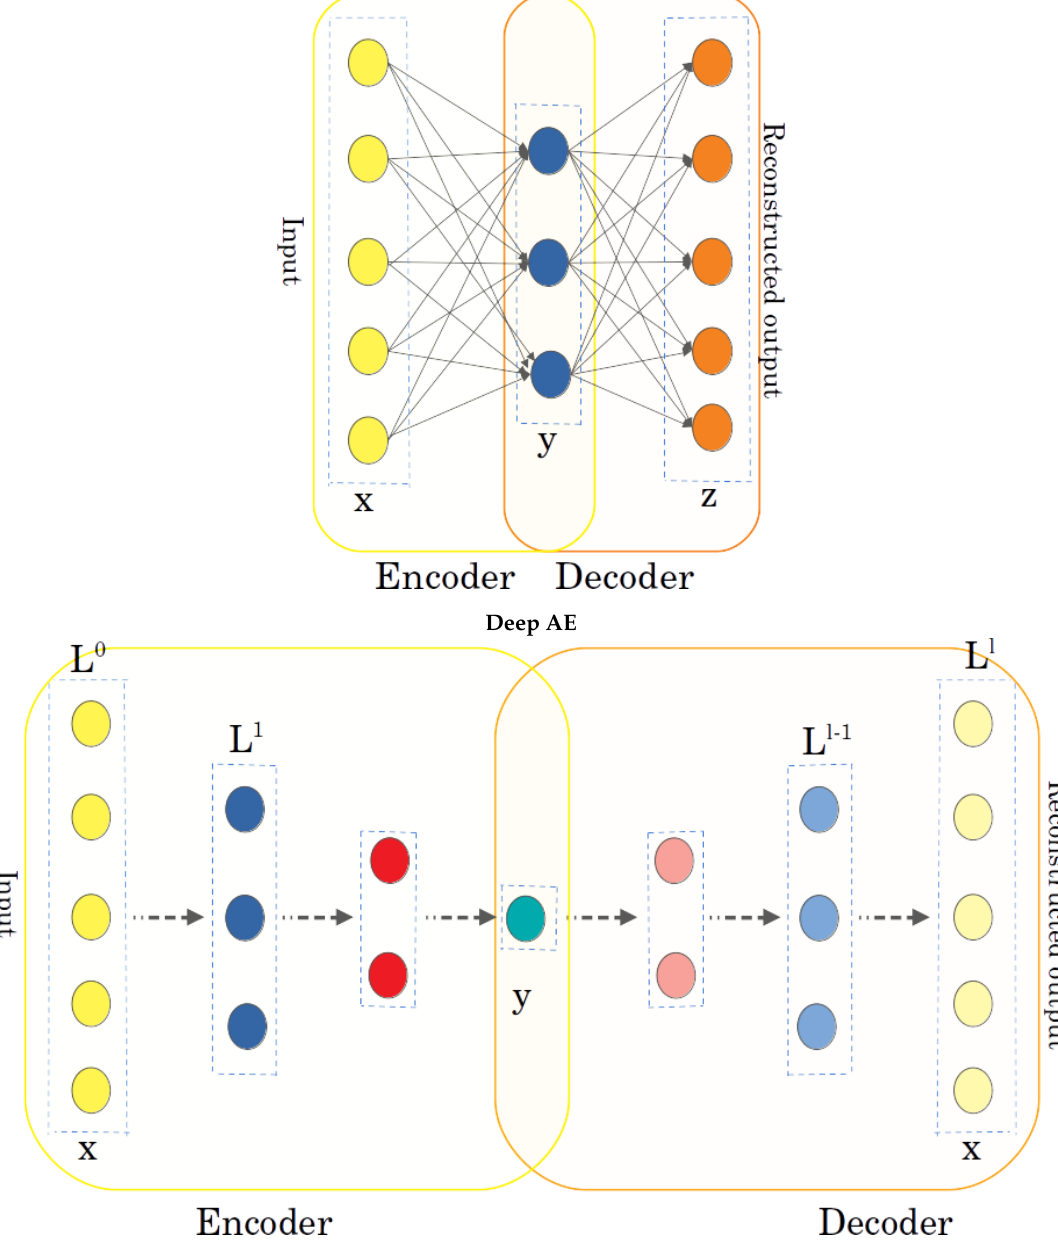
Figure 1. ( Top panel ): In a vanilla AE, the encoder maps x directly to y , and the decoder maps y directly to z . ( Bottom panel ): In a deep, non-stacked architecture, the encoder and decoder contain several hidden